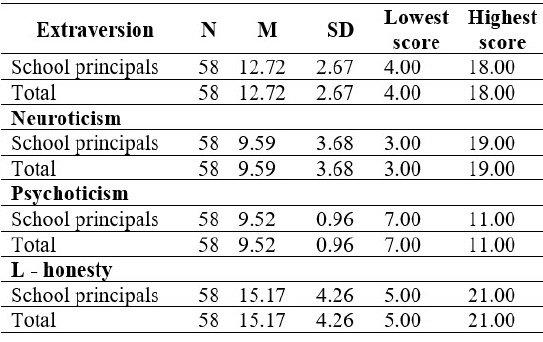
Table 3. Basic statistical indicators for extraversion, neuroticism and